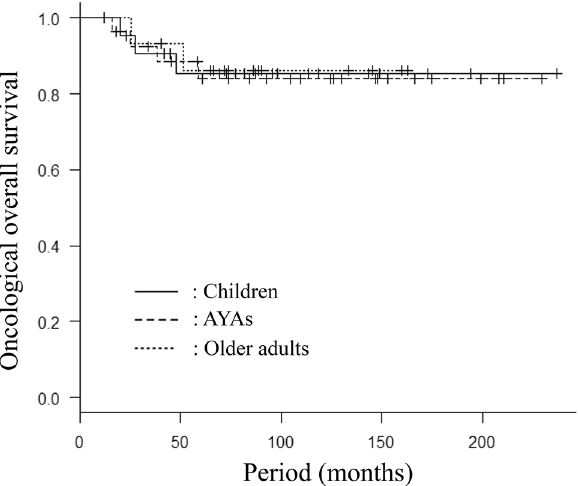
Figure 2. Overall survival (OS) in the three age group patients who underewent frozen autograft reconstruction. Excluding the cases with distant metastasis observed at the first visit, the 5-year and 10-year OS rates in AYA patients (n = 27) were 84% and 84%, while those in children (n = 5) and older adult patients (n = 15) were 85% and 85%, and 86% and 86%, respectively ( p = 0.98).